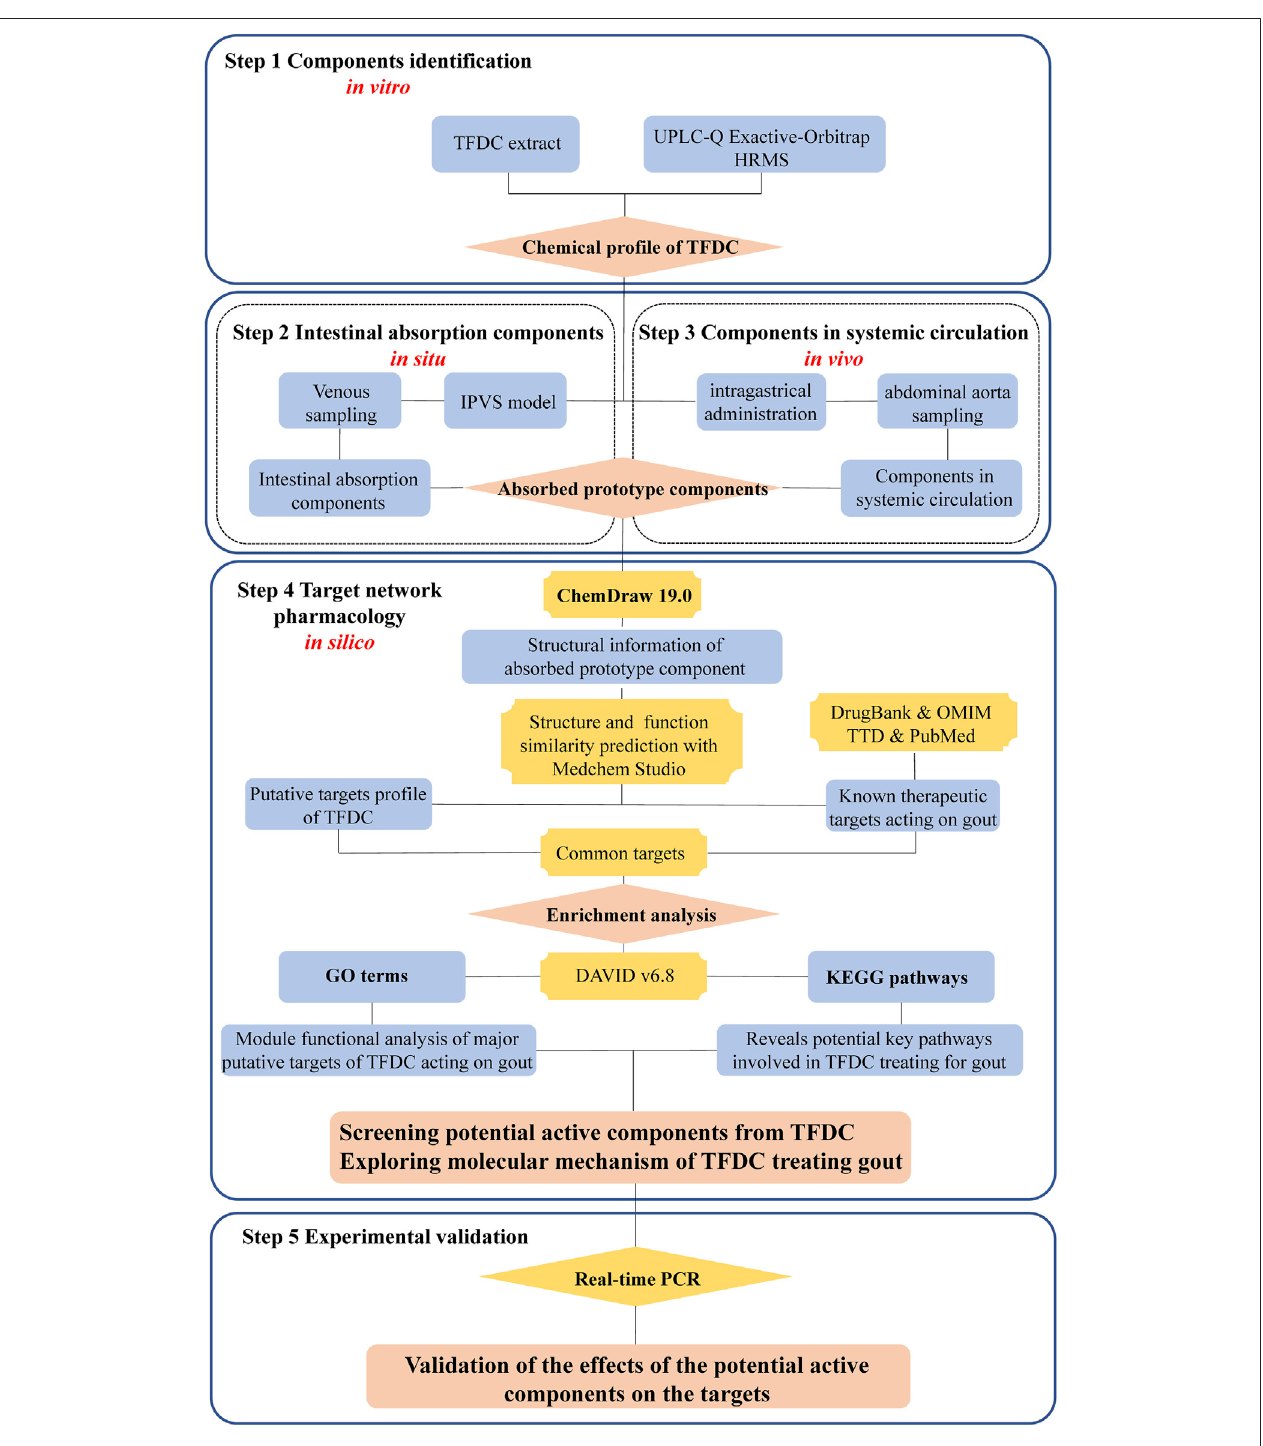
FIGURE 1 | Flowchart of the study